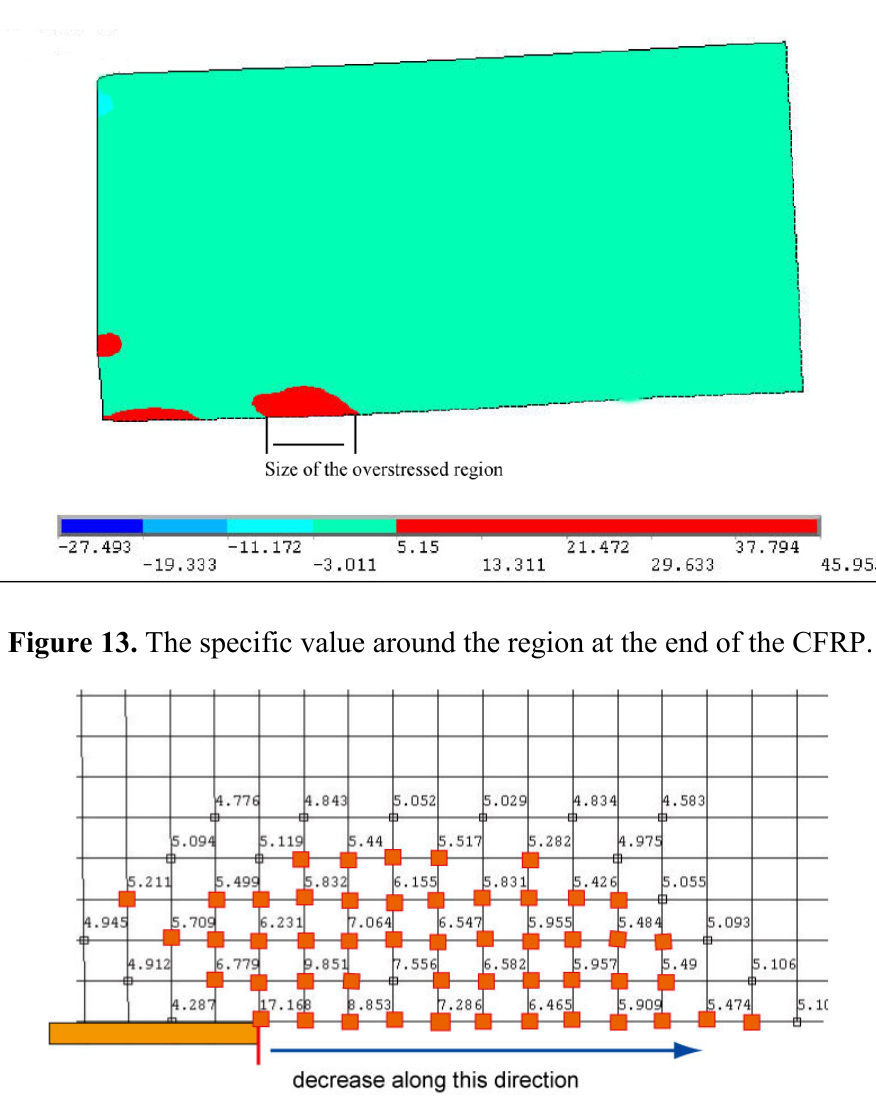
Figure 12. The distribution for the maximum principle stresses in concrete material at the end of CFRP with a length of 0.10 m.